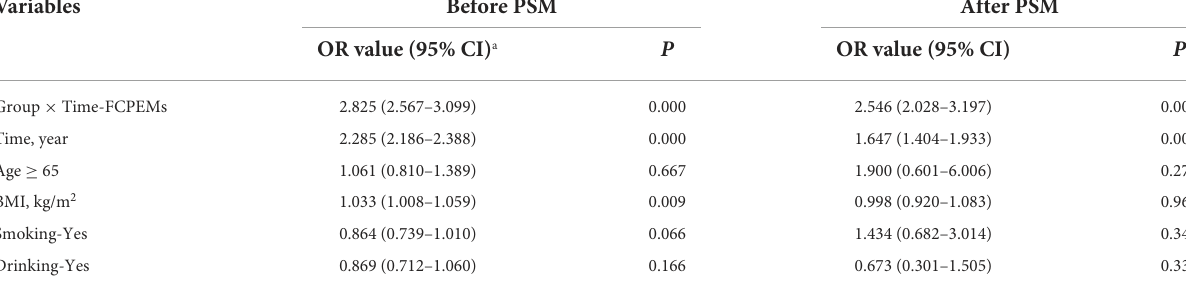
TABLE 3 Fixed-effect regression analysis of the effect of FCPEMs on medication adherence.